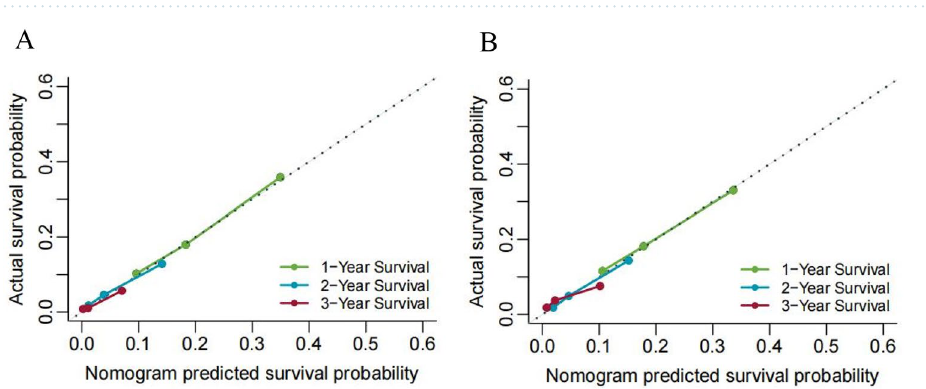
Figure 6. The calibration curves of the nomograms for overall survival (OS) predictions at 1 , 2 and 3 years in the primary ( A ) and validation cohorts ( B